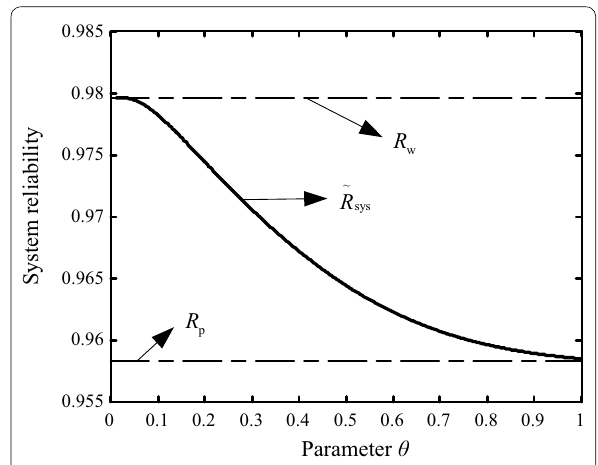
Figure 1 Changing curve of system reliability along with parameter reliability model established in Section 3. The final allo- cation failure rates of each subsystem are denoted as ˆ (cid:31)